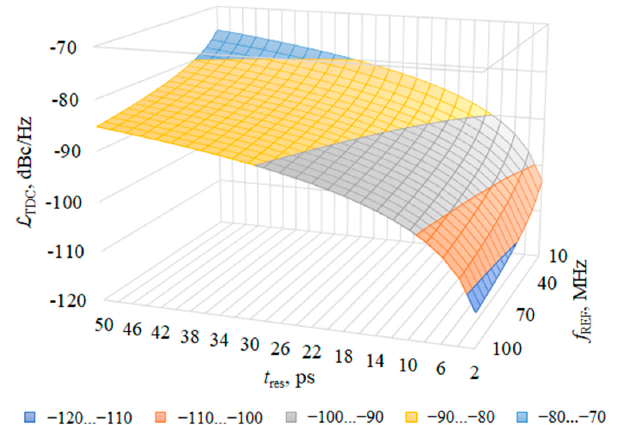
Figure 3. Calculated phase noise induced by time to digital converter, when frequency of digitally controlled oscillator’s output signal is 6 GHz, frequency of reference signal is 10–100 MHz, resolution of time to digital converter is 2–50 ps.